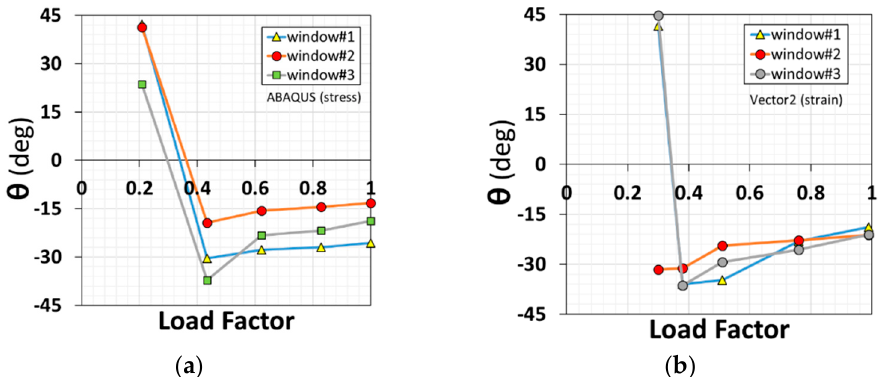
Figure 8. Variations in the angle of inclination of the web-shear crack according to the load factor. ( a ) ABAQUS. ( b ) Vector2.